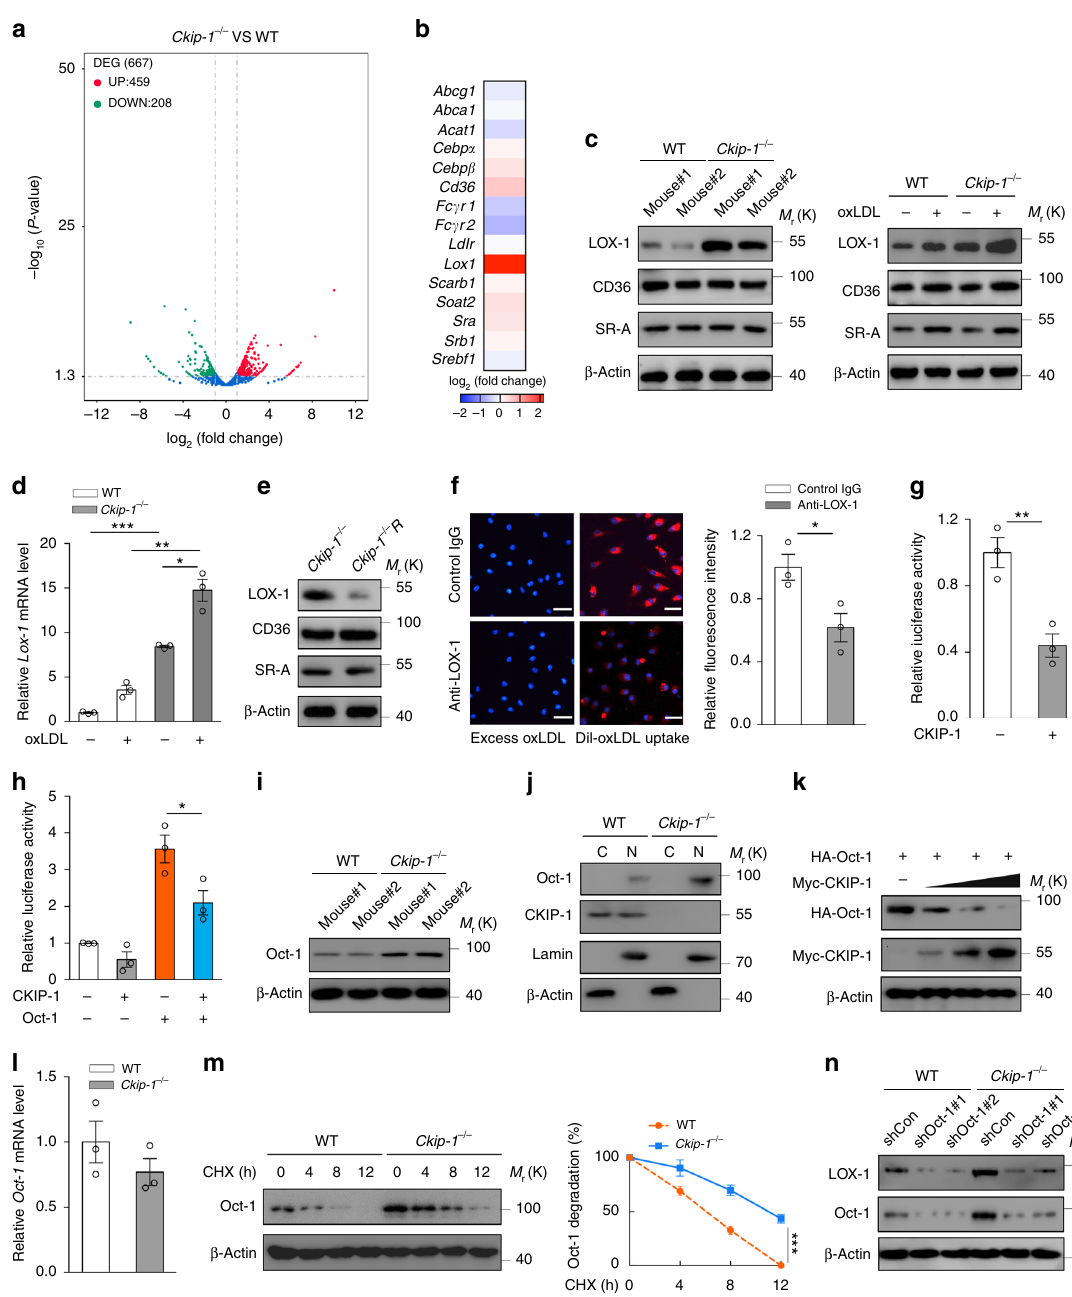
Fig. 2 CKIP-1 diminishes Oct-1-mediated LOX-1 expression. a , b WT and Ckip-1 − / − BMDMs were analyzed RNA sequencing. Identi fi cation of the DEGs was graphed in volcano plot ( a ) and selected genes involved in foam cell formation ( b ) are shown as a heatmap. c Expression of LOX-1, CD36, and SR-A in WT and Ckip-1 − / − BMDMs after 24 h incubation with or without 20 μ g per ml oxLDL. d mRNA levels of LOX-1 in BMDMs after incubation with or without oxLDL (20 μ g per ml) for 24 h. e Expression of LOX-1, CD36, and SR-A in Ckip-1 − / − and Ckip-1 − / − R BMDMs. f Ckip-1 − / − macrophages were incubated with anti-LOX-1 antibody (10 μ g per ml) or control goat IgG for 1 h prior to the addition of Dil-oxLDL or excess unlabeled oxLDL. Total uptake of Dil-oxLDL in each group was quanti fi ed. Scale bar, 25 μ m. g , h Luciferase assay in HEK293T cells were transfected with the LOX-1/pGL3 luciferase plasmid and other plasmids as indicated. The luciferase activities were represented after normalization against renilla luciferase activity. i Expression analysis of Oct-1 in WT and Ckip-1 − / − BMDMs. j The nuclear and cytoplasmic protein samples from WT and Ckip-1 − / − BMDMs were subjected to western blot analysis. β